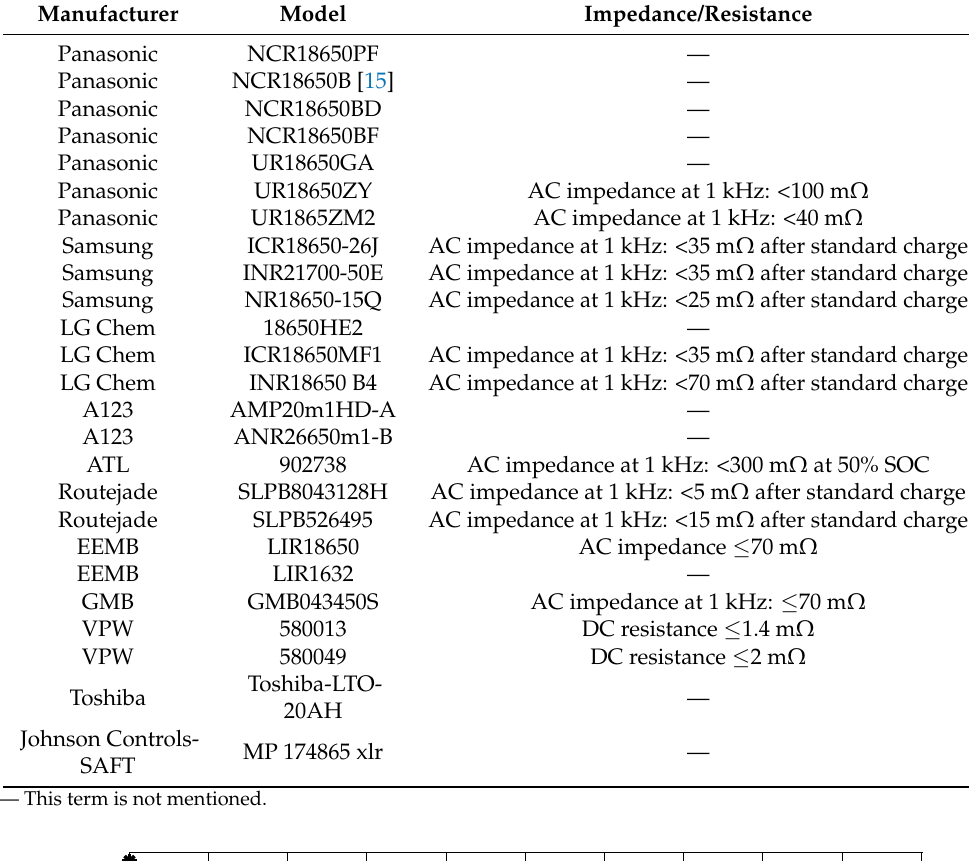
Table 5. Impedance/resistance.